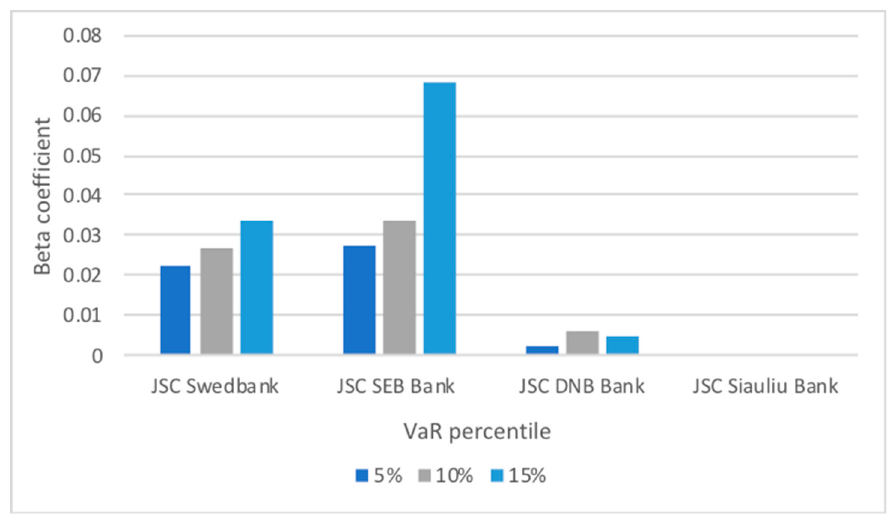
Figure 2. Beta coefficient sensitivity analysis to the VaR parameter.